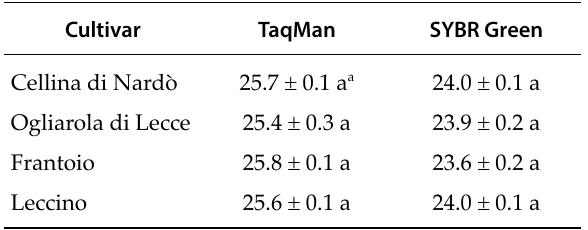
Table 2. Mean threshold cycles (C t ) of the calibrator chal- cone synthase gene assayed by qPCR, using TaqMan or SYBR Green fluorescent chemistry.